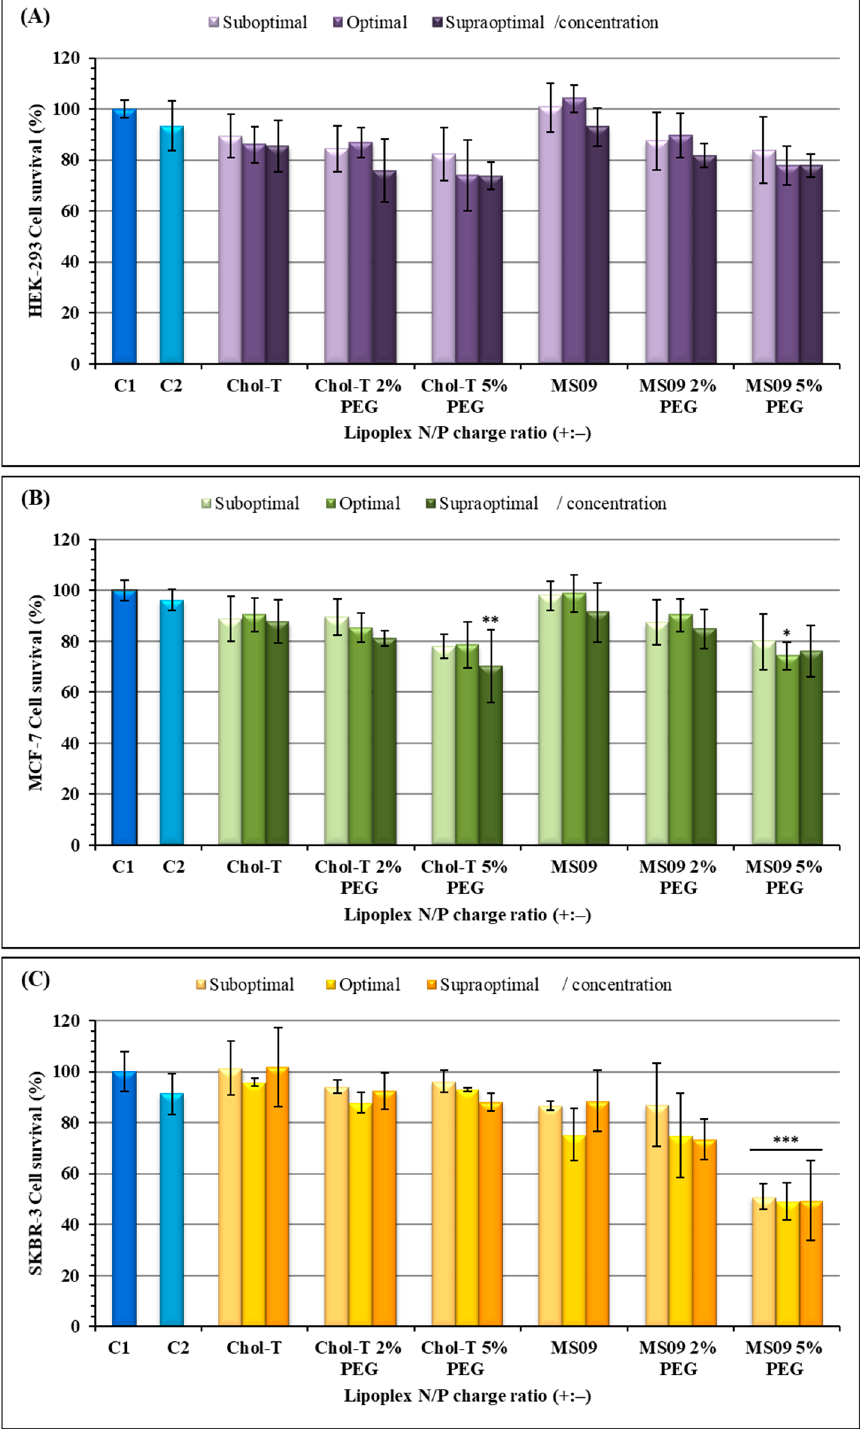
Figure 4. Cell viability studies of siRNA lipoplexes in ( A ) HEK293, ( B ) MCF-7, and ( C ) SKBR-3 cells in vitro. Incubation mixtures contained 0.32 µg of siRNA with varying amounts of liposome from suboptimal to supraoptimal N/P (+: − ) charge ratios: Chol-T (3.4, 3.9, 4.4); Chol-T 2% PEG (5.8, 6.3, 6.8); Chol-T 5% PEG (8.3, 8.8, 9.3); MS09 (4.9, 5.4, 5.9); MS09 2% PEG (5.5, 6.0, 6.5); MS09 5% PEG (7.4, 7.9, 8.4). C1 = cells only- untreated), and C2 = Lipofectamine3000 treated cells. Data are presented as means ± SD (n = 3). * p < 0.05, ** p < 0.01, and *** p < 0.001 were considered statistically significant vs. the cell control.